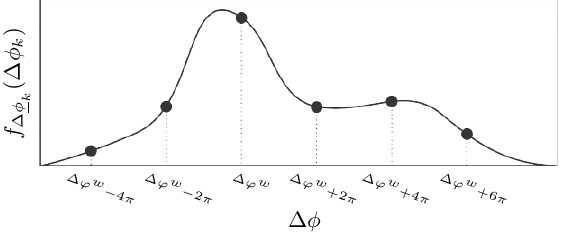
Figure 1. A general example of PDF of unwrapped phase gradient. The black dots gives the descrite probability mass function after enforcing congruence (not scaled).